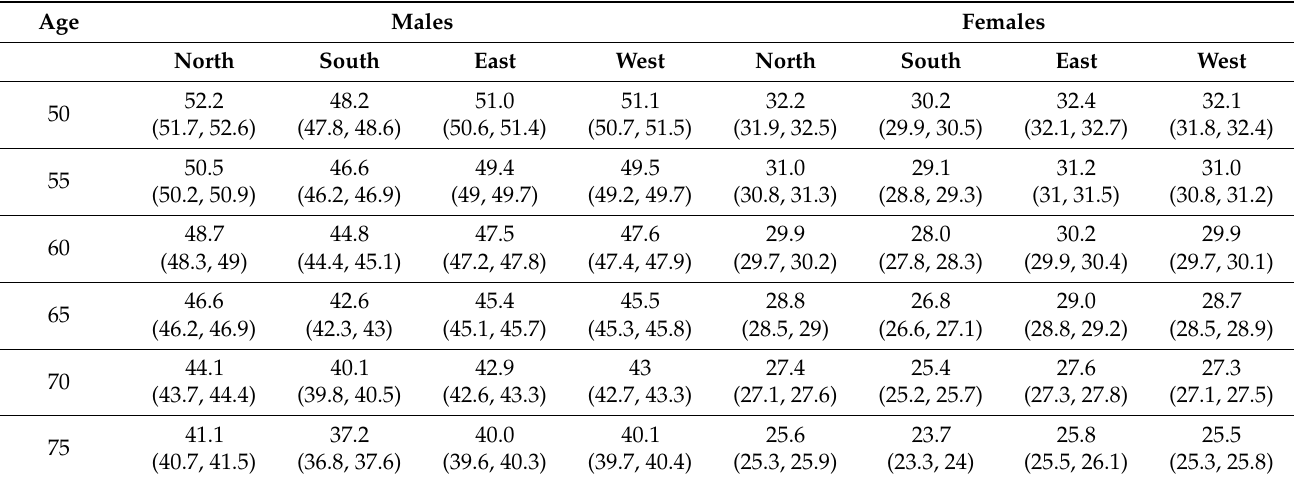
Table 3. Grip strength reference values (mean, 95% confidence intervals) if engaged in weekly vigorous physical activity.